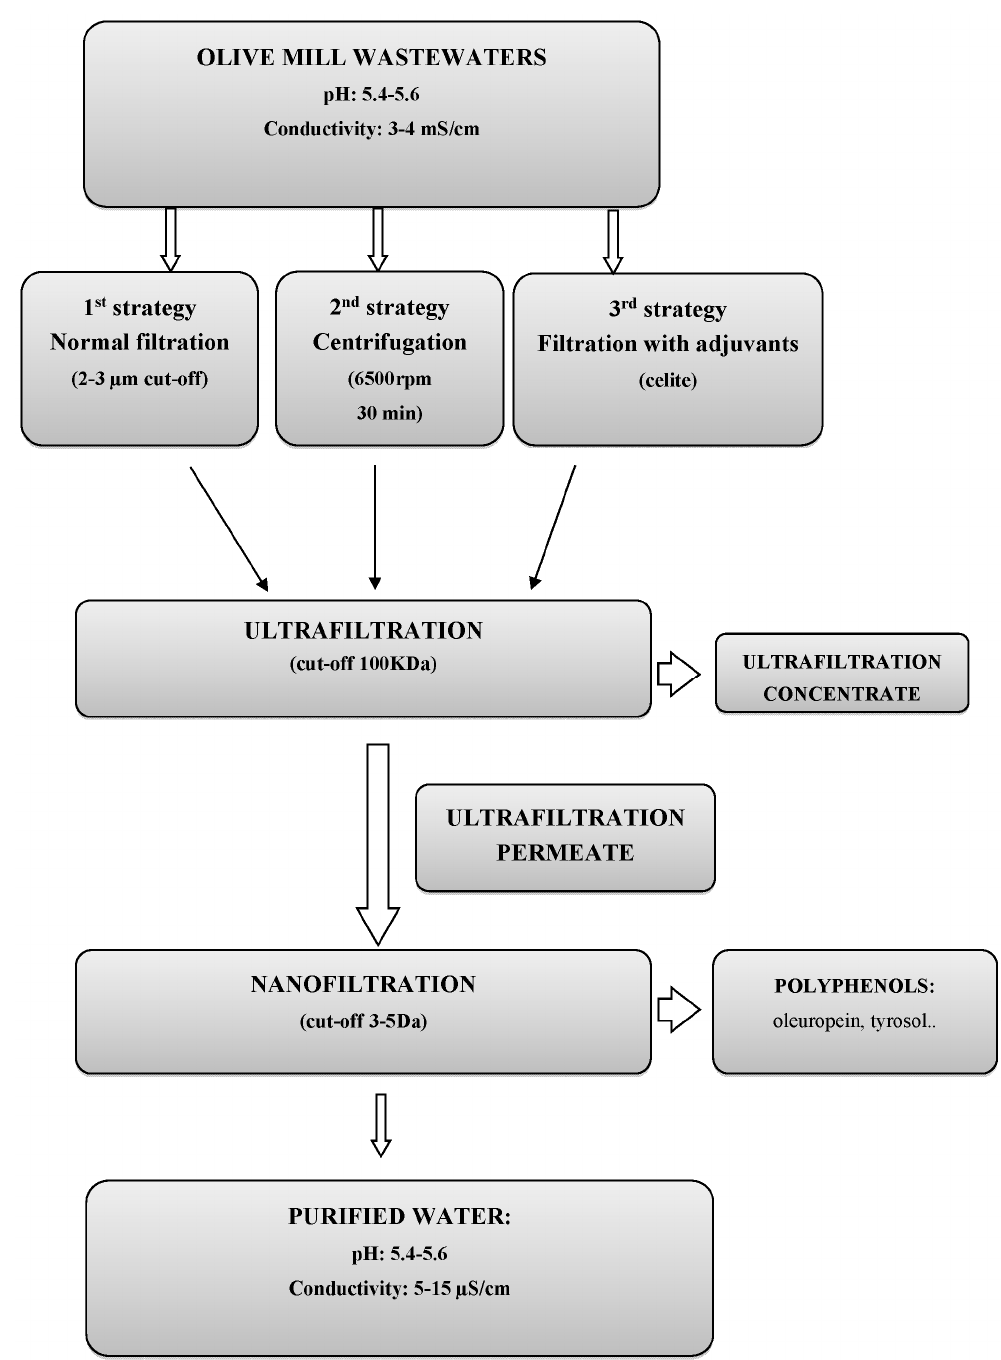
Figure 2. Block diagram of the process.